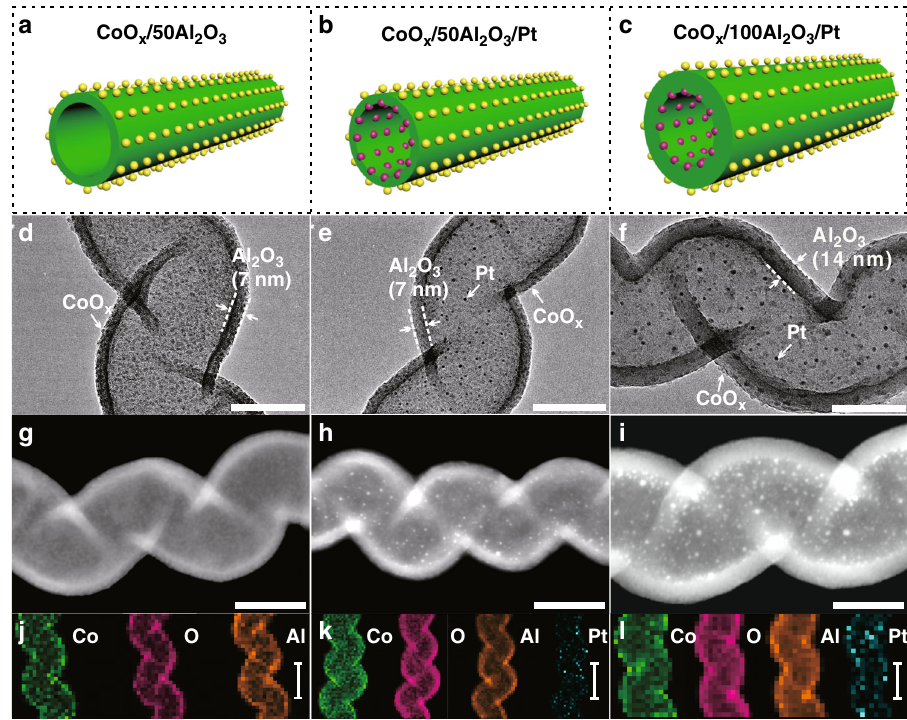
Fig. 1 Structural characterization of the catalysts. a – c Structure diagrams (The green tubes represent Al 2 O 3 . The magenta and yellow balls represent Pt and CoO x , respectively), d – f TEM images (scale bar, 50 nm), g – i HAADF-STEM images (scale bar, 50 nm), and j – l EDX elemental mappings (scale bar, 100 nm) of the catalysts. a , d , g , j : CoO x /50Al 2 O 3 ; b , e , h , k : CoO x /50Al 2 O 3 /Pt; and c , f , i , l CoO x /100Al 2 O 3